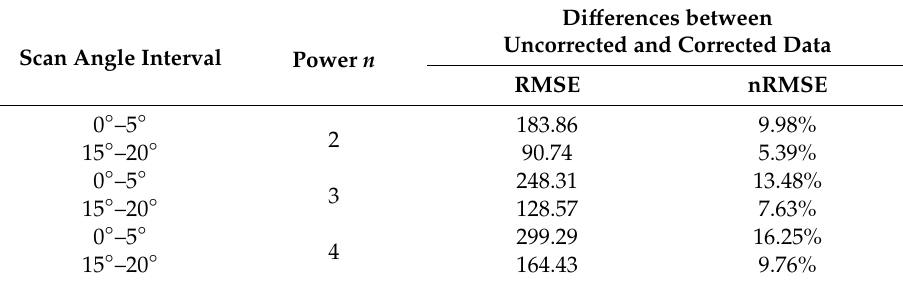
Table 3. RWE di ff erences between the radiometrically uncorrected and corrected